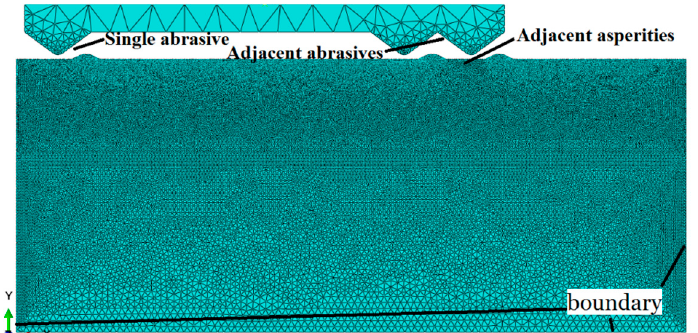
Figure 2. Meshing model of abrasive particles in contact with the asperity.